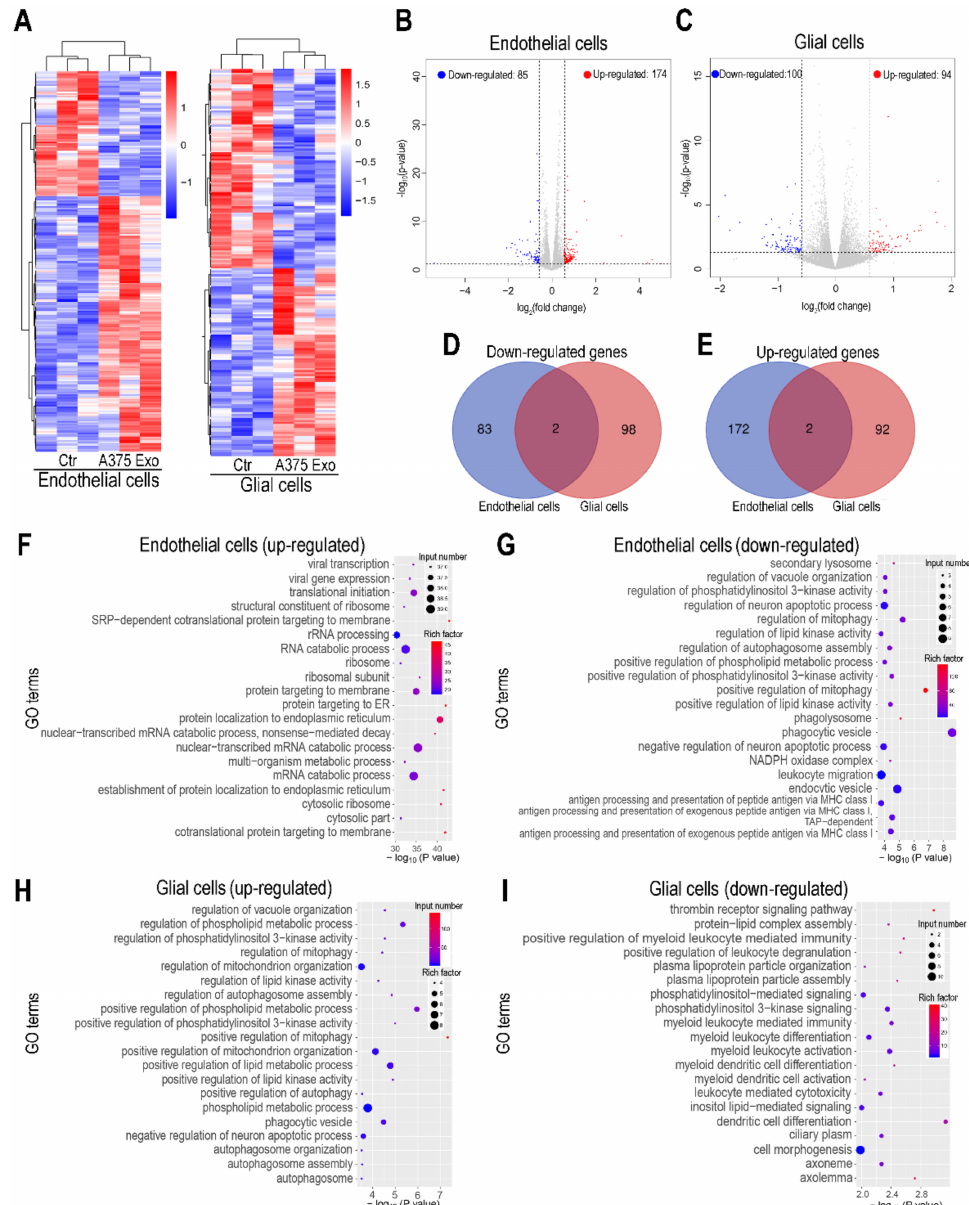
Figure 4. RNA-seq analysis of brain endothelial cells and glial cells following treatment of A375 cell-derived exosomes on the BBB chip. ( A ) Heat-map showing the transcriptional changes of brain endothelial cells and glial cells on BBB chip 3 days after treatment of A375 cell-derived exosomes ( n = 3). ( B , C ) Volcano plots showed the modulated genes in brain endothelial cells ( B ) or glial cells ( C ) 3 days after treatment of A375 cell-derived exosomes. Genes differentially expressed with fold- change >1.5 and p < 0.05 were marked in color. p -values were calculated using a two-sided, unpaired Student’s t-test with equal variance assumed. ( D ) Venn diagrams depicted the down-regulated DEGs shared or unique between brain endothelial cells and glial cells. ( E ) Venn diagrams depicted the up-regulated DEGs shared or unique between brain endothelial cells and glial cells. ( F , G ) Dotplot showed the enriched GO terms based on up-regulated ( F ) or down-regulated ( G ) genes in brain endothelial cells following treatment of A375 cell-derived exosomes. ( H , I ) Dotplot showed the enriched GO terms based on up-regulated ( H ) or down-regulated ( I ) genes in glial cells following treatment of A375 cell-derived exosomes. ( F – I ) The color of the dots represents the rich factor, and the size represents the input number for each GO